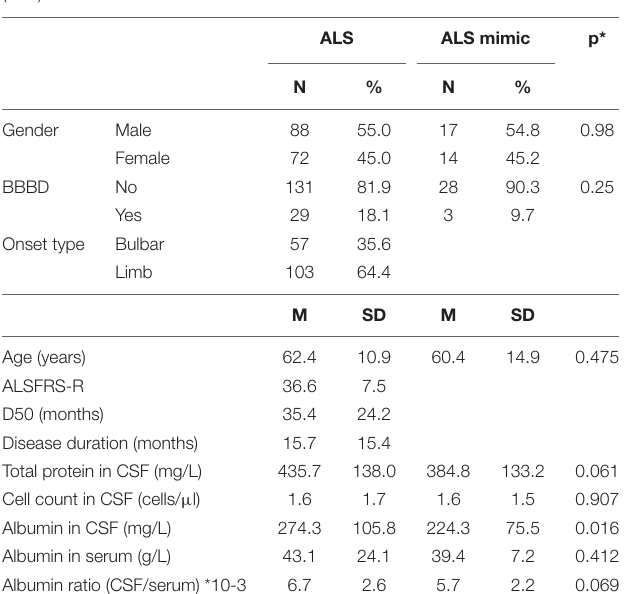
TABLE 1 | Characteristics of patients with amyotrophic lateral sclerosis (ALS) and ALS mimics.